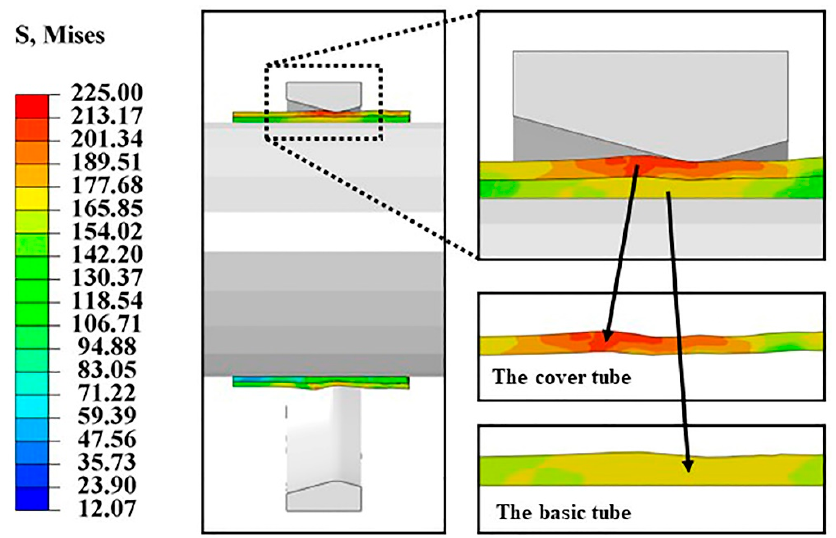
Figure 4. Distribution of radial equivalent stress during the rotary ring spinning of a bimetallic tube.